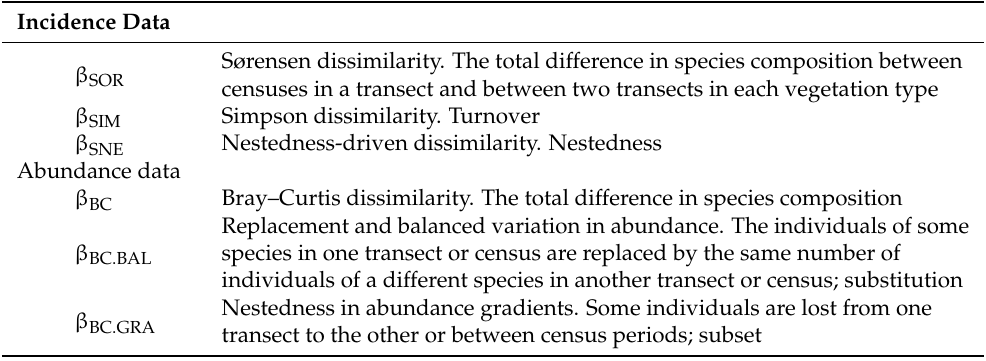
Table 1. β -diversity indices